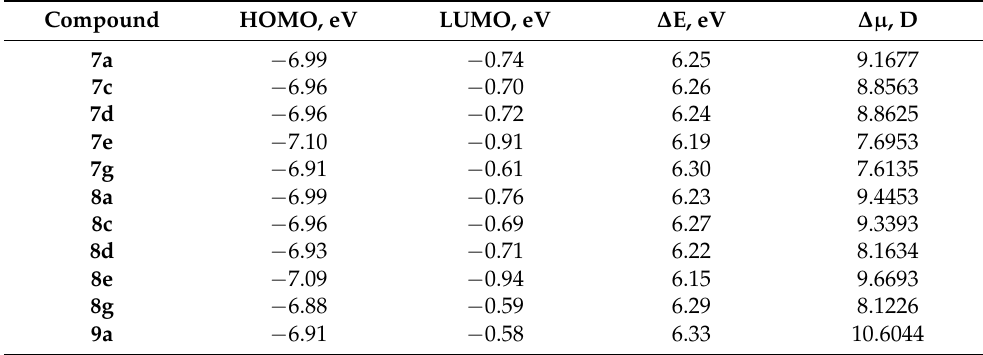
Table 3. HOMO/LUMO, energy gaps, and dipole moments in the ground state based on functionality CAM-B3LYP/6-31+G* in the gas